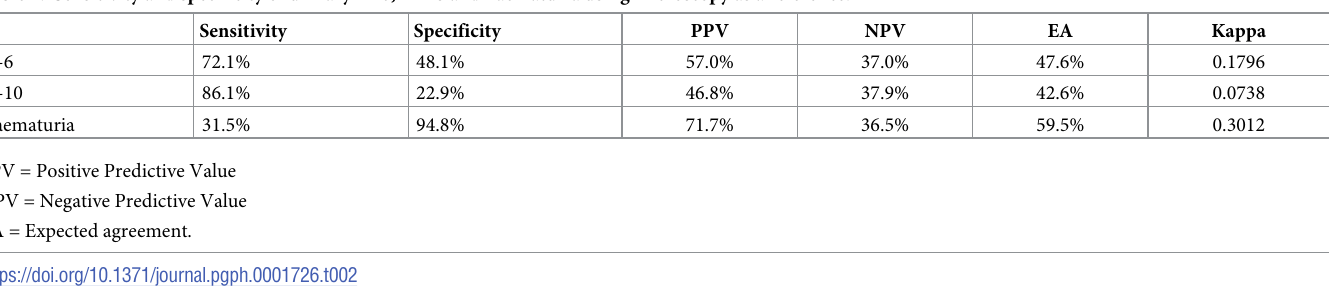
Table 2. Sensitivity and specificity of urinary IL-6, IL-10 and haematuria using microscopy as a reference.